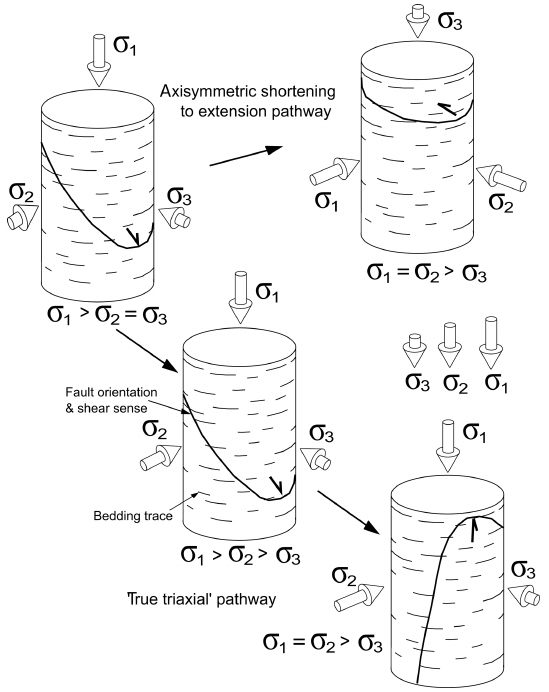
Figure 14. Illustration of different polyaxial loading test sequences for a transversely isotropic rock with constant bedding/foliation orientation. Relative lengths of arrows indicate relative values of principal stresses. Potential fault plane orientations and slip senses are indicated. Upper pathway corresponds to that used in the present exper- iments. Axial stress changes from maximum to minimum, and the relative values of the principal stresses change with respect to the transversely isotropic plane. Lower pathway corresponds to the sequence that might be employed in ‘true’ triaxial loading. Here, maximum stress can always be normal to the plane of transverse isotropy, but contrac- tional loading is applied across the foliation whereas in the upper path constriction is parallel to the isotropic